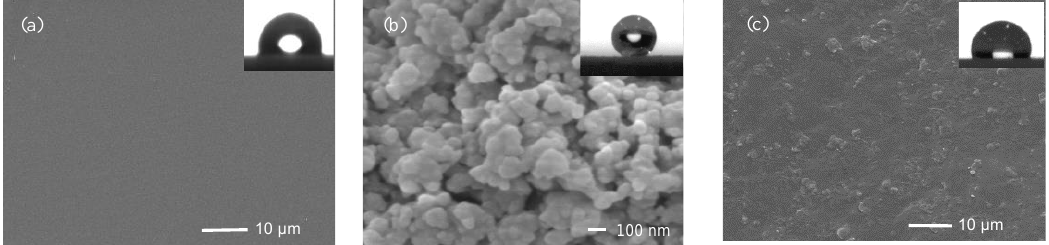
Figure 6. SEM images of different samples: ( a ) PSA10; ( b ) VTMO-SiO 2 ; and ( c ) HPS5.